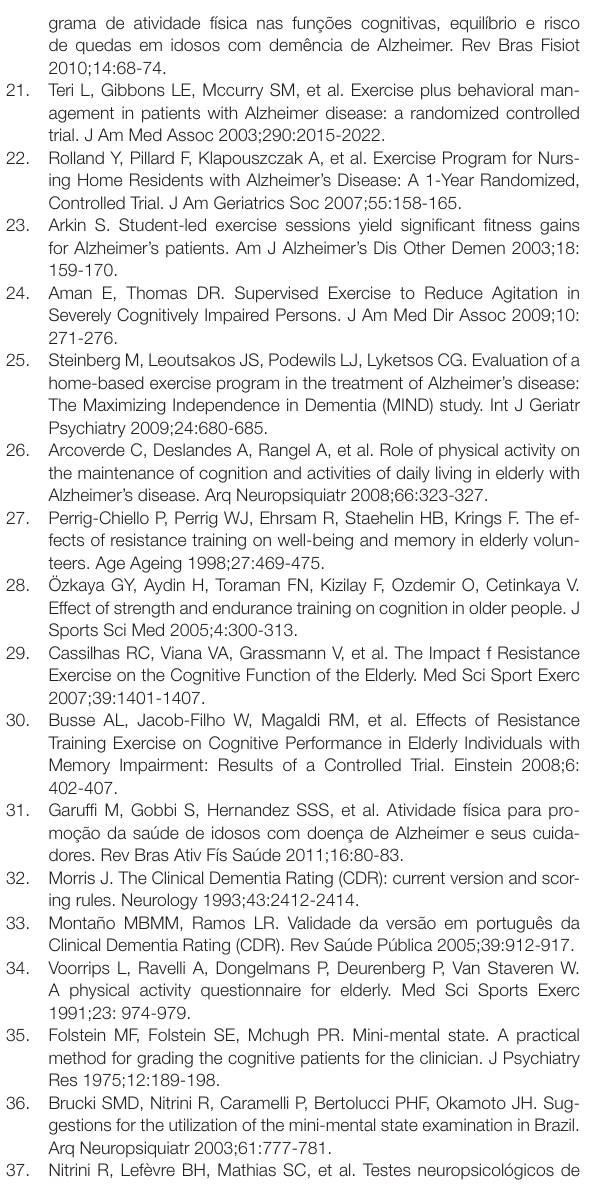
258 Physical exercises and cognitive functions in AD Vital TM, et